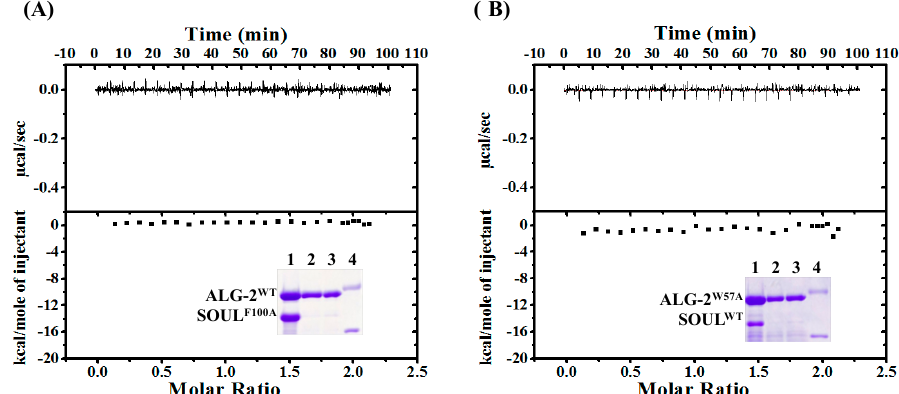
Figure 7. Calorimetric titrations and GST-pulldown analysis using SOUL F100A or ALG-2 W57A . Titrations of His-SOUL F100A to delta3-23ALG-2 WT ( A ) or His-SOUL WT to delta3-23ALG-2 W57A ( B ) were performed under the same conditions as described in Figure 3C. Insets show GST-pulldown analysis of His-SOUL F100A and GST-ALG-2 WT ( A ) or His-SOUL WT and GST-ALG-2 W57A ( B ) in the presence of 20 µ M Ca 2+ . Lane 1, input; lane 2, + 1 mM EGTA; lane 3, + 20 µ M Ca 2+ ; Lane 4, protein markers, 45 and 31 kDa.